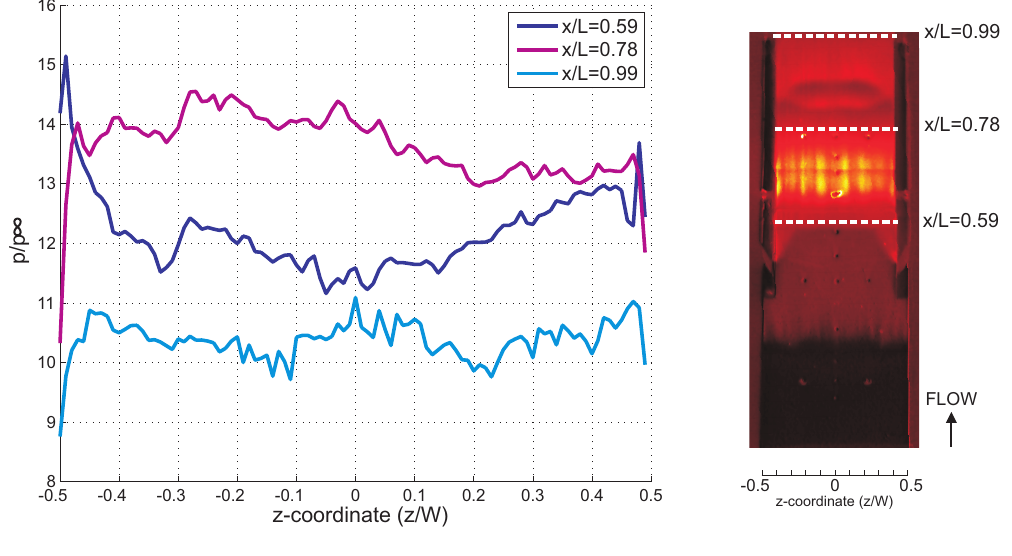
Figure 15. Normalized spanwise static pressure for the baseline case taken at the isolator entrance x / L = 0.59, the middle of the isolator x / L = 0.78 and the isolator exit x / L = 0.99.